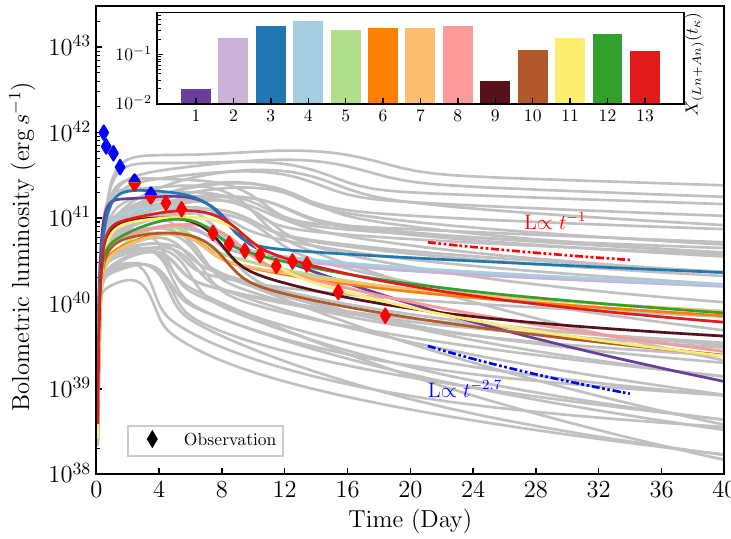
Figure 1. Bolometric luminosity of selected simulations with di ff erent eject masses. The subplot in the top is mass fractions of lanthanides ( Ln ) and actinides ( An ), X Ln + An at one day after merger. Blue and red diamond markers are observed bolometric luminosity. Dash-doted lines with labels of L ∝ t − α show power fit to the bolometric luminosity. The colored lines show light curve simulations that are closest to the AT2017gfo observation of the inferred ejecta masses grid. The inferred ejecta masses used for each colored lines are 0 . 05 M (cid:4) , 0 . 02 M (cid:4) , 0 . 01 M (cid:4) , 0 . 01 M (cid:4) , 0 . 01 M (cid:4) , 0 . 02 M (cid:4) , 0 . 02 M (cid:4) , 0 . 05 M (cid:4) , 0 . 08 M (cid:4) , 0 . 08 M (cid:4) , 0 . 02 M (cid:4) , 0 . 05 M (cid:4) by order. The grey lines shows the light curves with the rest of ejecta mass grid for each simulations. This figure is made from same calculations as in figure 8 and 12 from